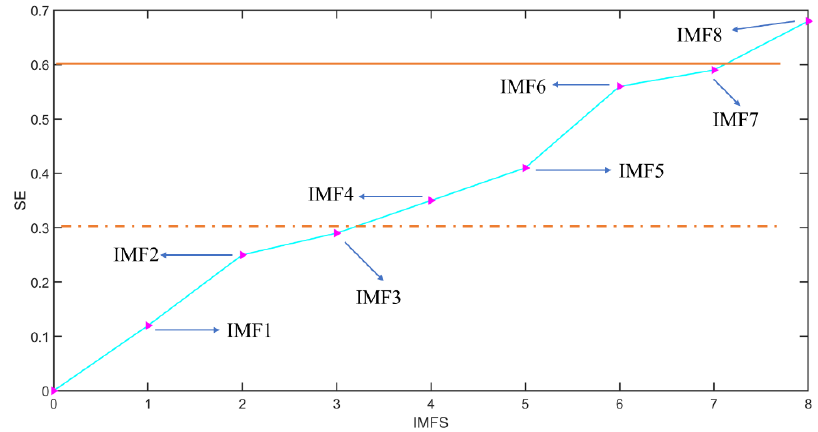
Figure 16. Noise classification based on SE-VMD and CNN-LSTM.